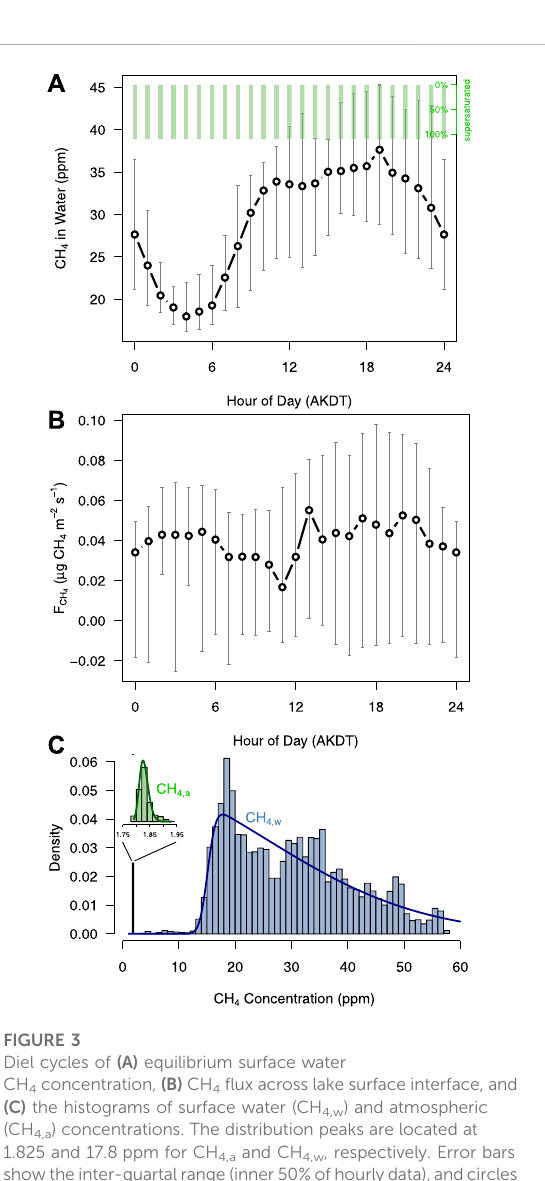
FIGURE 3 Diel cycles of (A) equilibrium surface water CH 4 concentration, (B) CH 4 fl ux across lake surface interface, and (C) the histograms of surface water (CH 4,w ) and atmospheric (CH 4,a ) concentrations. The distribution peaks are located at 1.825 and 17.8 ppm for CH 4,a and CH 4,w , respectively. Error bars showtheinter-quartalrange(inner50%ofhourlydata),andcircles are hourly